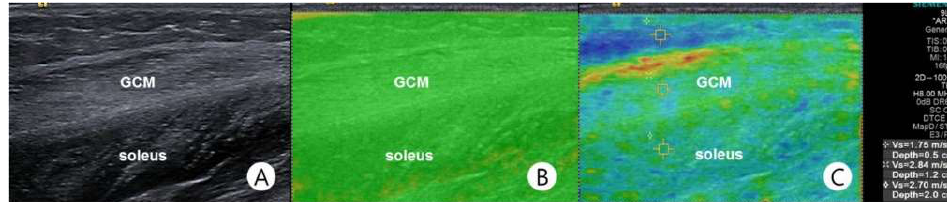
Figure 2. Representative longitudinal acoustic radiation force impulse (ARFI) image of the medial gastrocnemius muscle. ( A ) B-mode ultrasonography. ( B ) “Quality map” indicates the quality and reliability of the shear wave measurements. These correspond to the areas where the shear waves with sufficient quality for quantification are shown in green. ( C ) The shear-wave velocity (2.84 m/s) was measured in the region of interest of the medial gastrocnemius muscle using ARFI imaging.